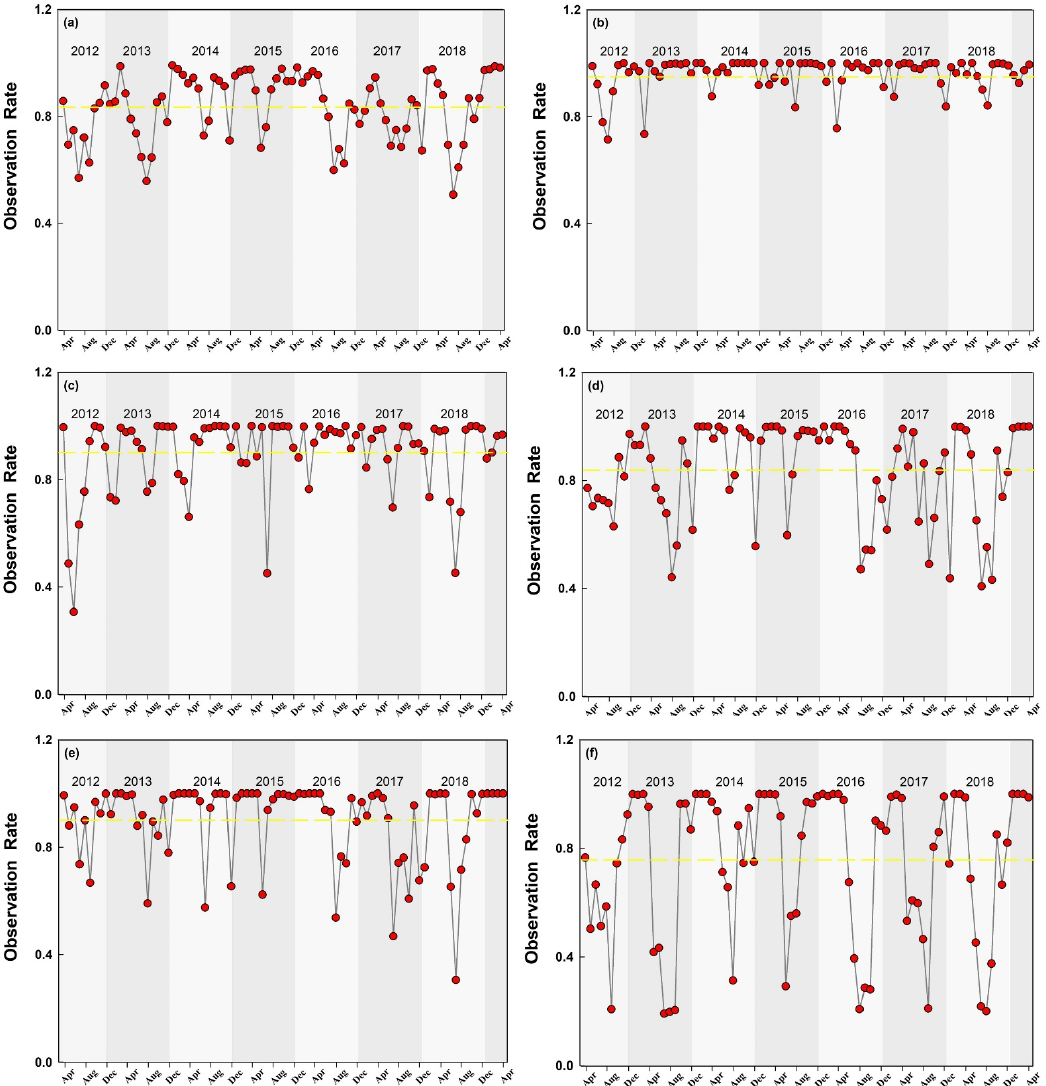
Figure 14. Observation rate results in the SCS: ( a ) the observation rate across the SCS ( b ) the observation rate in the Pearl River ( c ) the observation rate in the Gulf of Tonkin ( d ) the observation rate in eastern and southern Vietnam ( e ) the observation rate in the pelagic region ( f ) the observation rate in the Gulf of Thailand. The yellow line is the annual-averaged value.